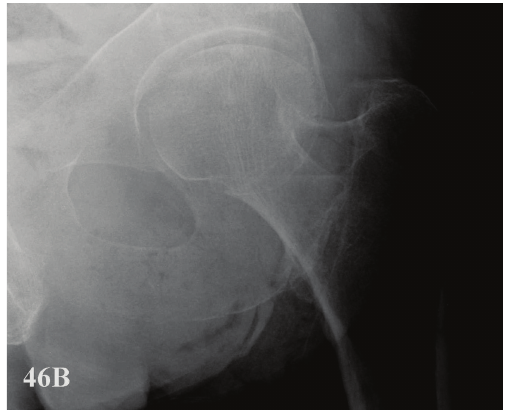
F 4: Bristol hip view demonstrating the importance of correct tube angulation. Over angulation of the beam means the fracture could be confused with the posterior border of the